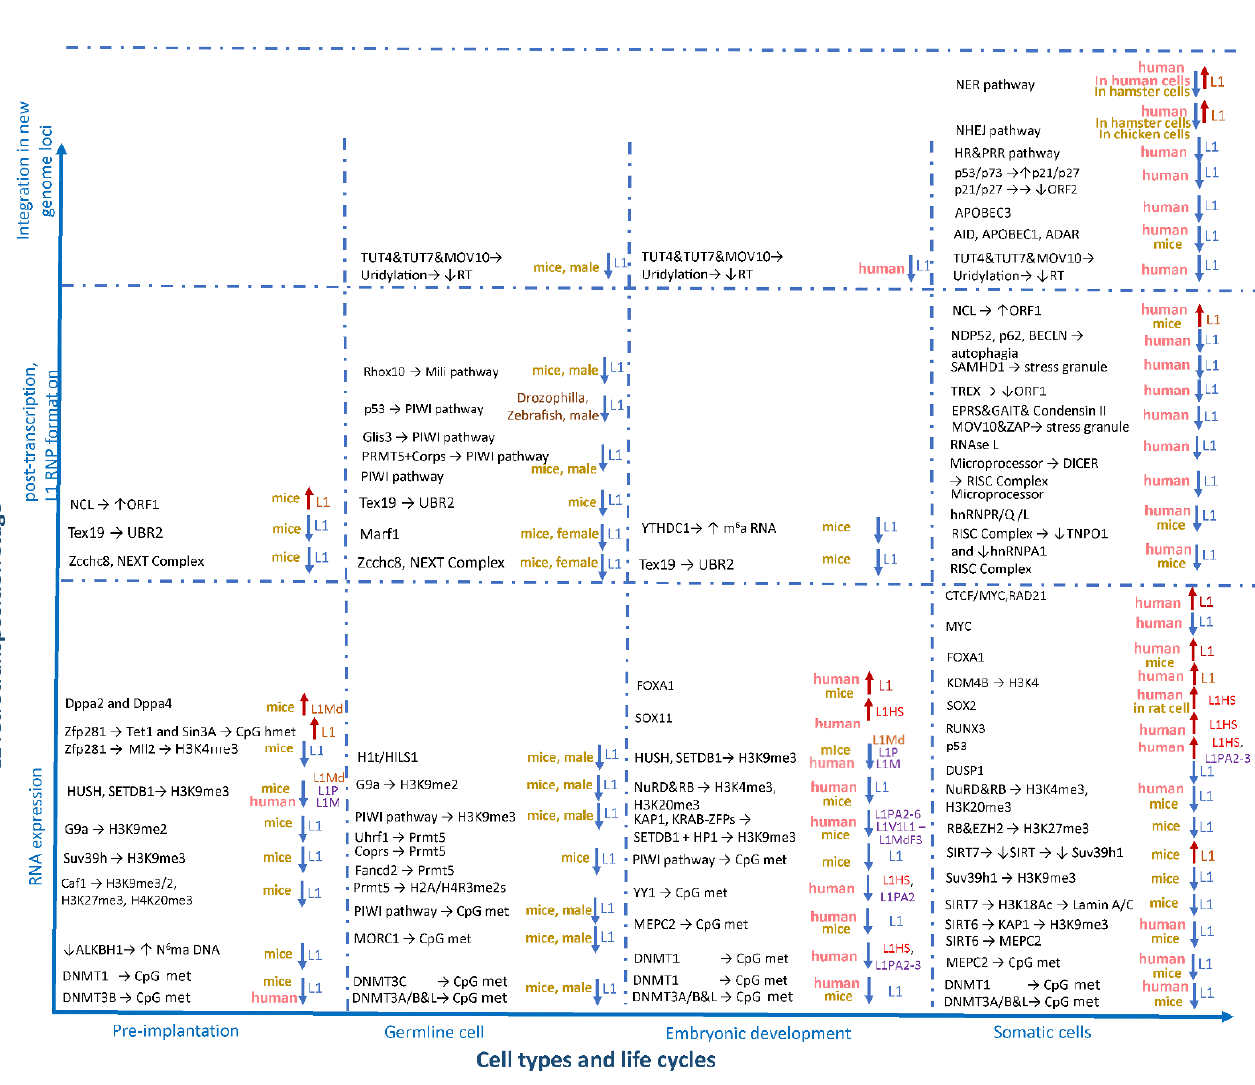
Figure 3. Factors affecting the activity of L1 retrotransposons during ontogenesis. The factors involved in L1 regulation are grouped horizontally in accordance with the stages of prenatal development (pre- and post-implantation period and in germline cells) and the postnatal period (somatic cells), as well as vertically depending on the stage of the retrotransposition process (expression, L1 RNP formation, and integration into the genome).